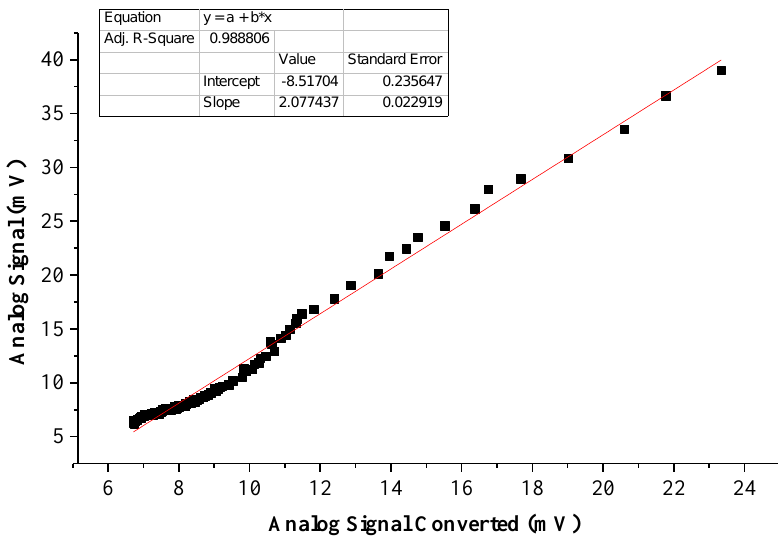
Figure 11. Linear relationship between AD signal and AD signal converted from PC signal after piecewise fitting.